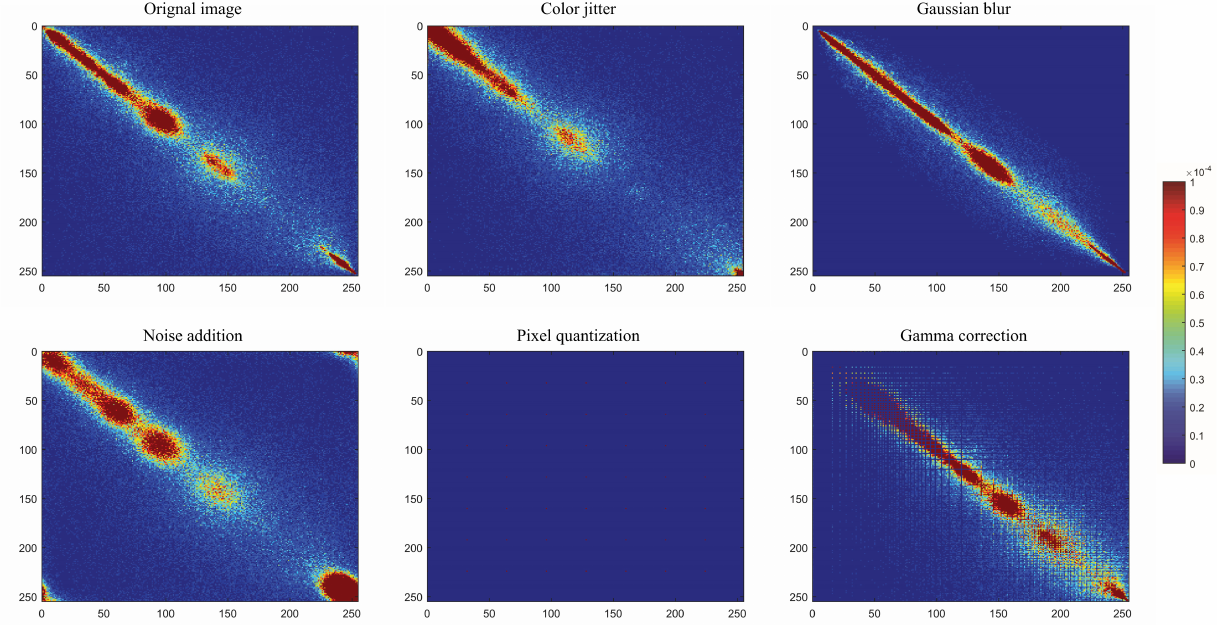
Figure 4. Normalized co-occurrences (shown as heatmaps) of two horizontally neighboring pixels in the green channel of the six images in Figure 2. In each sub-figure, the horizontal and vertical axes represent two pixels’ values (between 0 and 255). The color map used to represent normalized co-occurrence values in the six sub-figures is given at the rightmost of the figure. Zoom-in is recommended to well observe the red dots in the sub-figure of the pixel quantization